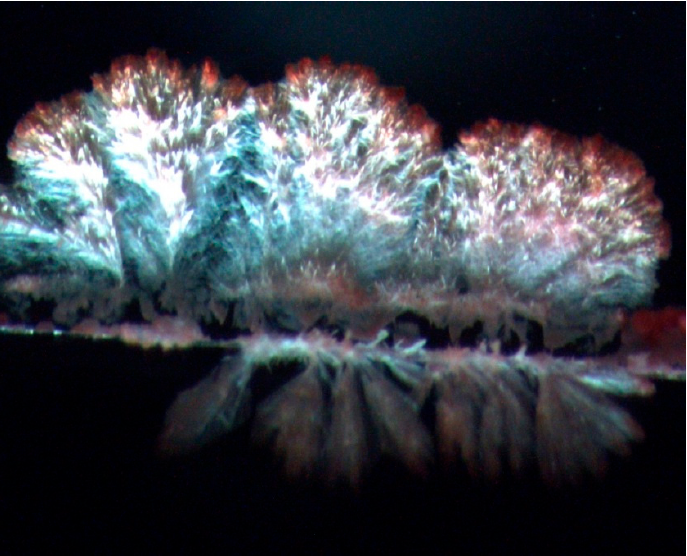
Figure 1. Caffeine crystals coloured by safranin under the transmitted light of a microscope (40x magnification).